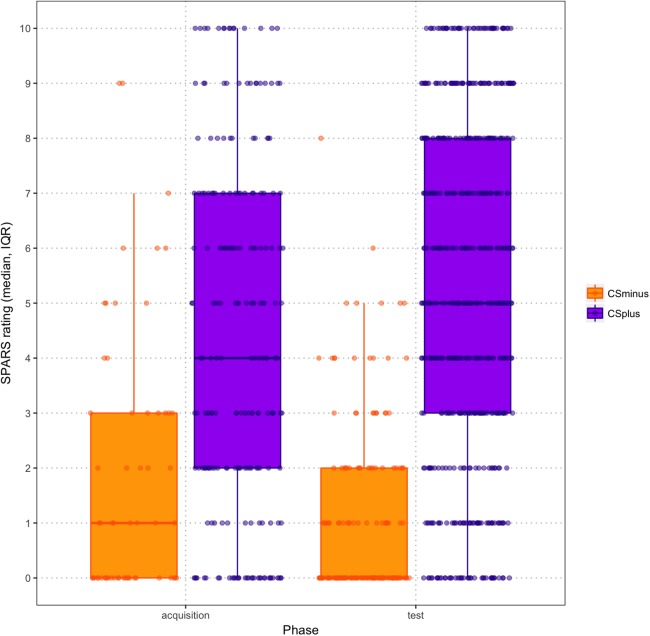
Scatter boxplots of exact mean intensity ratings (error bars = standard error) by CS type during acquisition and test phase.